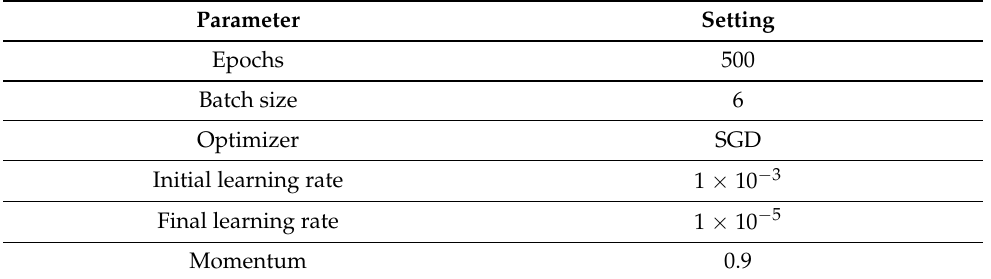
Table 1. Parameters for the model